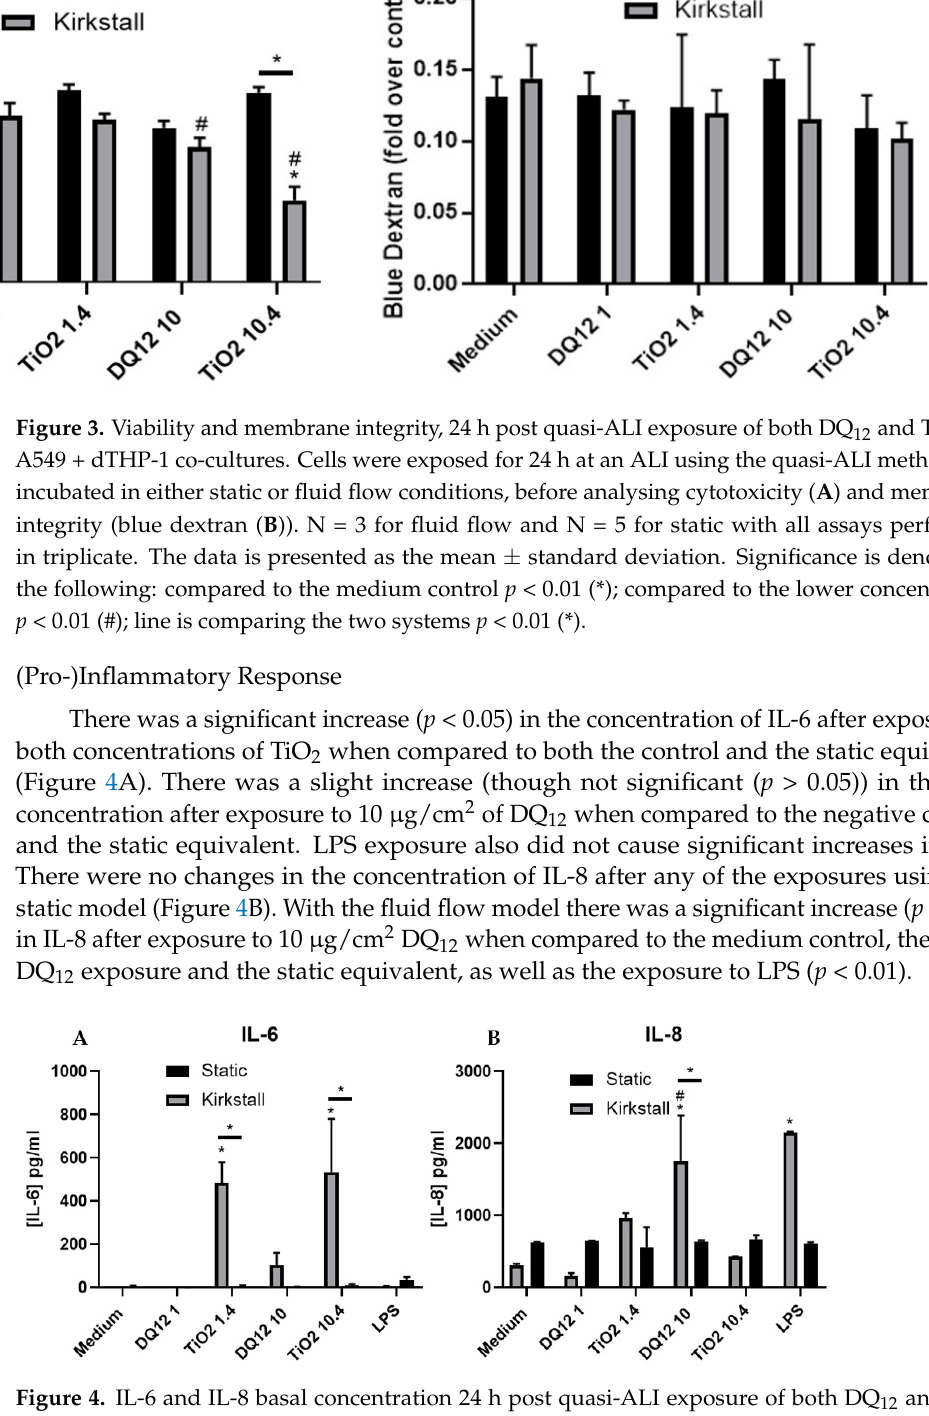
Figure 4. IL-6 and IL-8 basal concentration 24 h post quasi-ALI exposure of both DQ 12 and TiO 2 on A549 + dTHP-1 co-cultures. Cells were exposed for 24 h at an ALI using the quasi-ALI method and left to incubate in either static or fluid flow conditions, before analysing IL-6 ( A ) and IL-8 ( B ) con- centrations in the basal compartment of the ALI culture after a single particle exposure (onto the apical side). N = 3 for fluid flow and N = 5 for static with all assays performed in triplicate. The data is presented as the mean ± standard deviation. Significance is denoted as the following: compared to the medium control p < 0.01 (*); compared to the lower concentration p < 0.01 (#); line is comparing the two systems p < 0.01 (*).